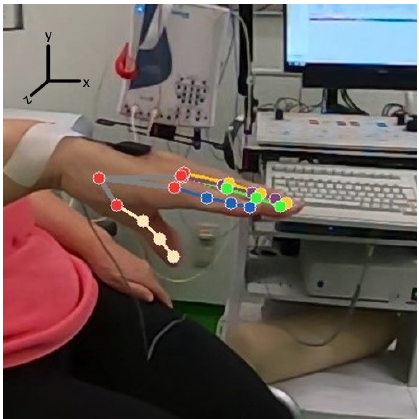
Figure 2. Example landmarks extraction process (beige: thumb, lilac: index finger, yellow: middle finger, green: ring finger, blue: little finger, red: wrist, carpometacarpal and metacarpophalangeal joints).